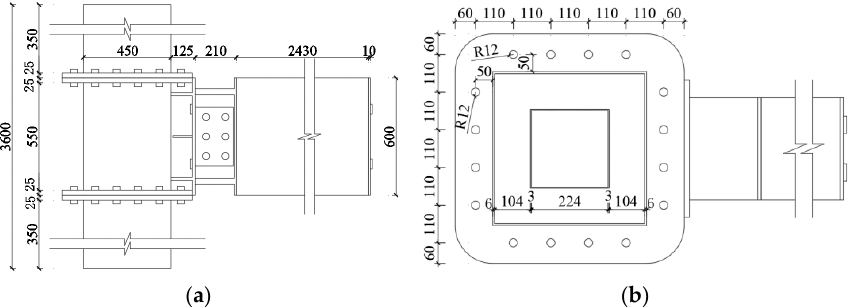
Figure 3. Dimensions of the joint (unit: mm): ( a ) Front view of the joint; ( b ) Top view of the joint.